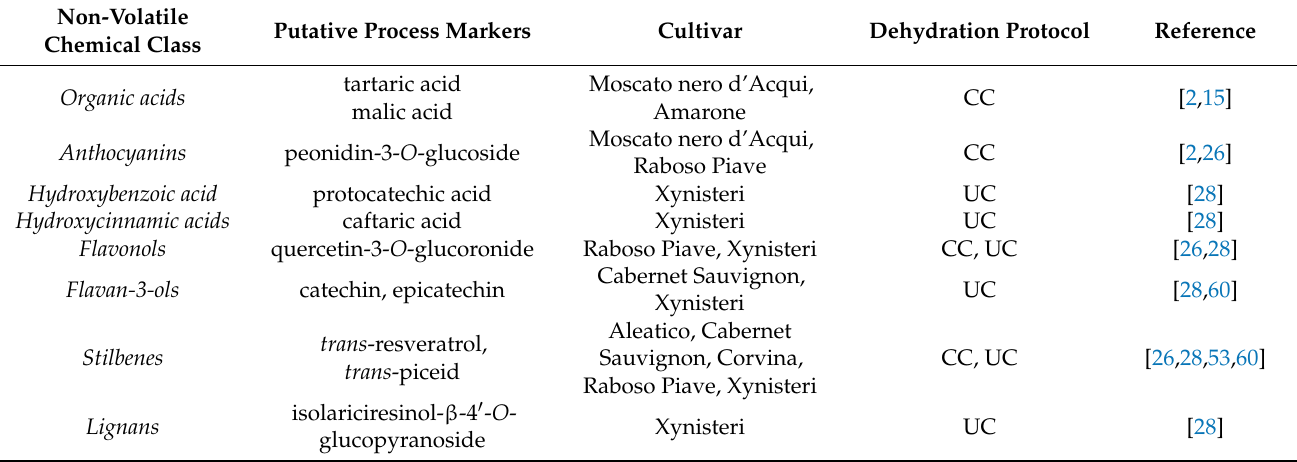
Table 3. Putative non-volatile markers of dehydration process in wine grape. CC: controlled conditions; UC: uncon- trolled